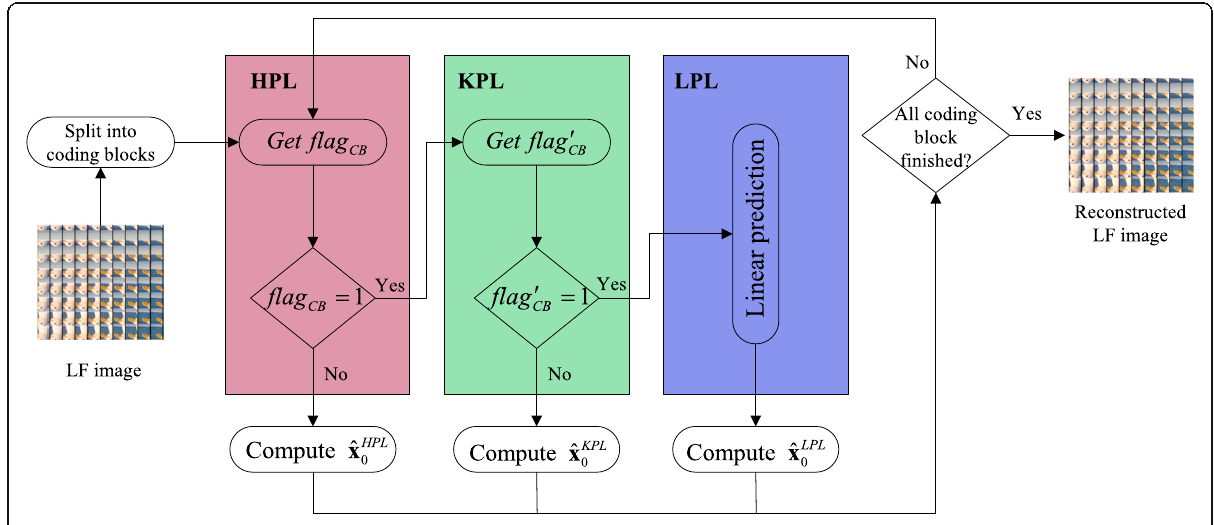
Fig. 4 Flow graph explaining SK-MMSE prediction